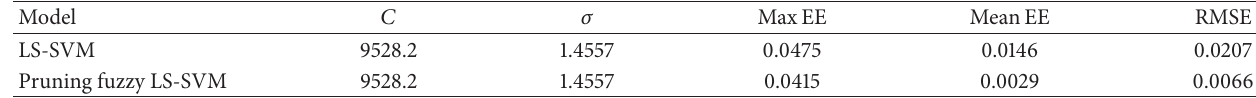
Table 2: Two-dimension function predicted results.